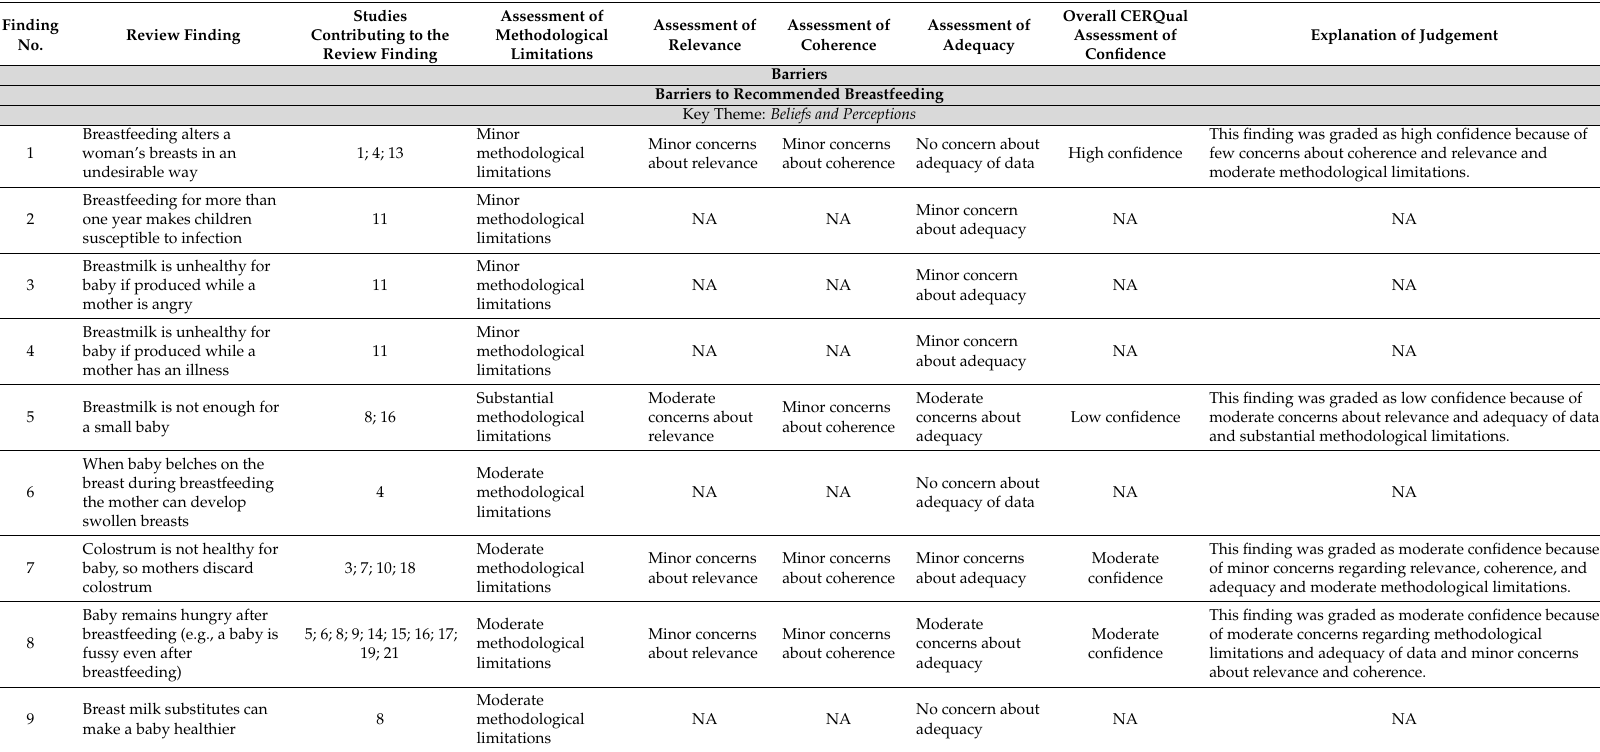
Table 2. CERQual qualitative evidence profile of identified barriers and